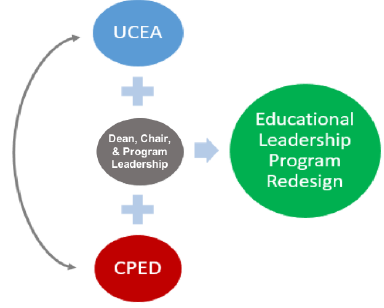
Figure 1. Conceptual Framework for Educational Leadership Doctoral Program Redesign. To that end, the planning ensued with the alignment of